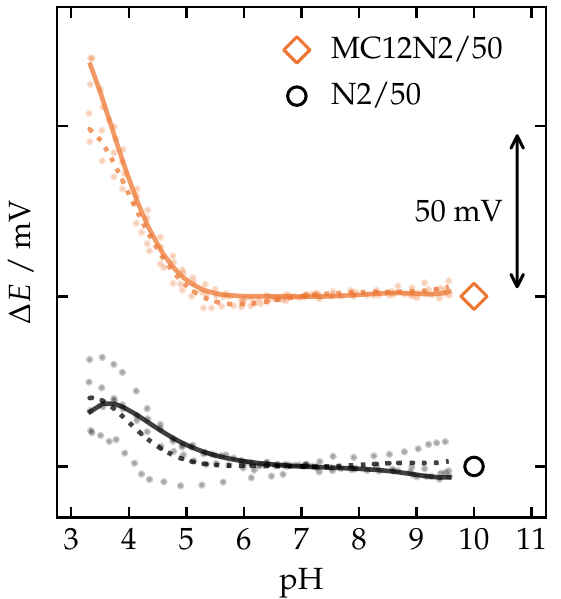
Figure 4. pH sensitivity of sensors with either the best-performing ion-selective membrane or its corresponding control membrane. Polynomials ( n = 7) fitted to the results of PVC- and PCTFE-shelled sensors are shown as solid and dotted lines, respectively. Measurements were performed in 10 − 2 M acetic acid titrated with a mixture of 0.25 M NaOH and 10 − 2 M sodium acetate. See Table 1 for membrane compositions.